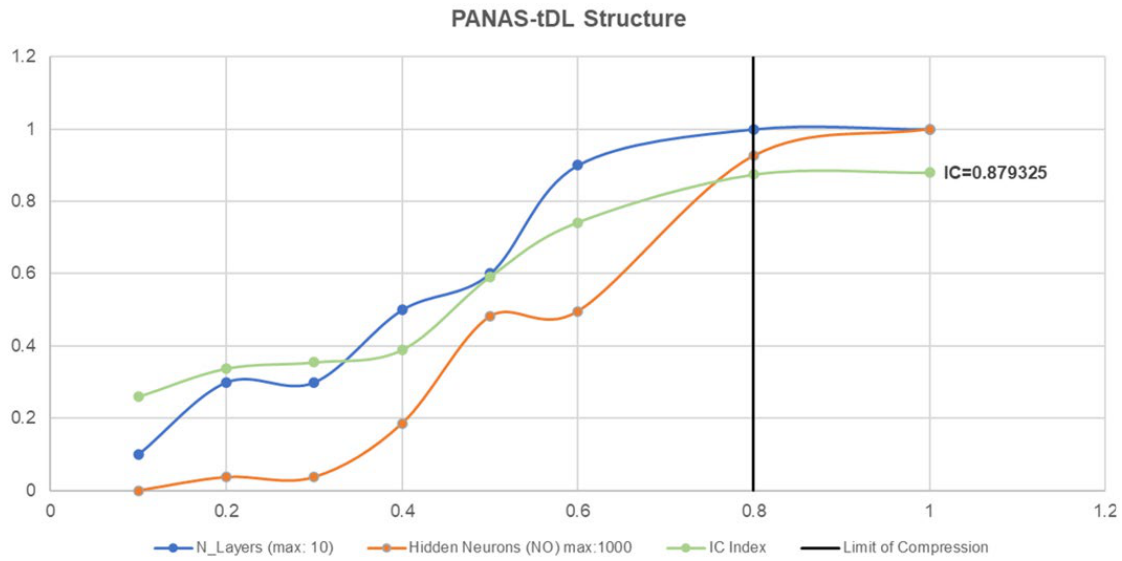
Figure 2. PANAS-tDL model